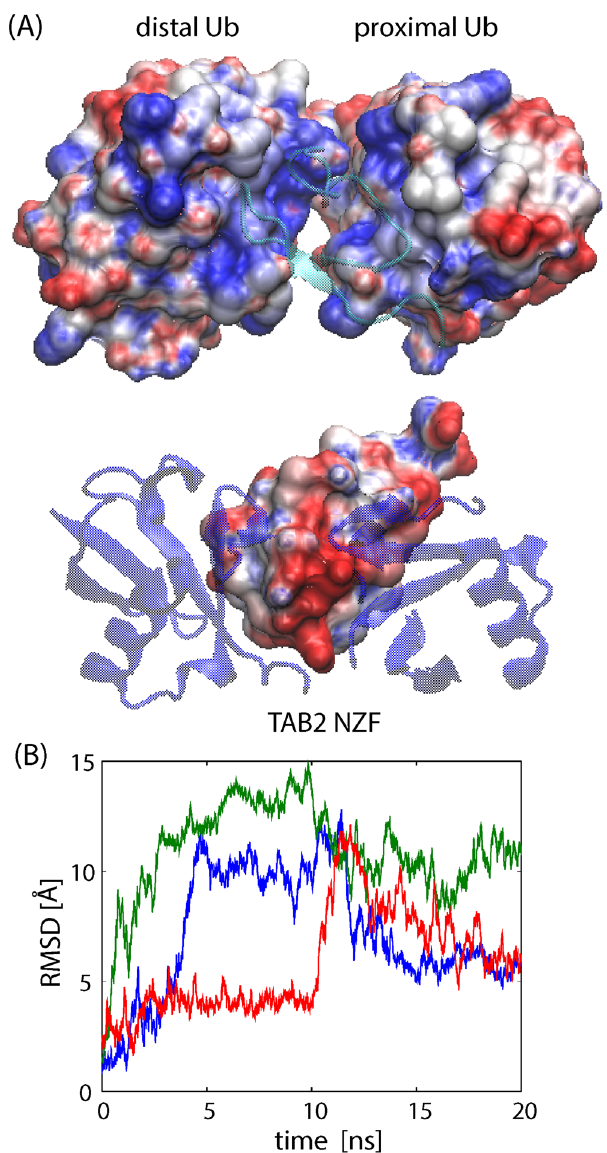
C α RMSD for three MD simulations (colored in red, blue, and green) of free K63 di-Ub (core regions, 1–70) starting from the crystal structure of the complex after removing TAB2